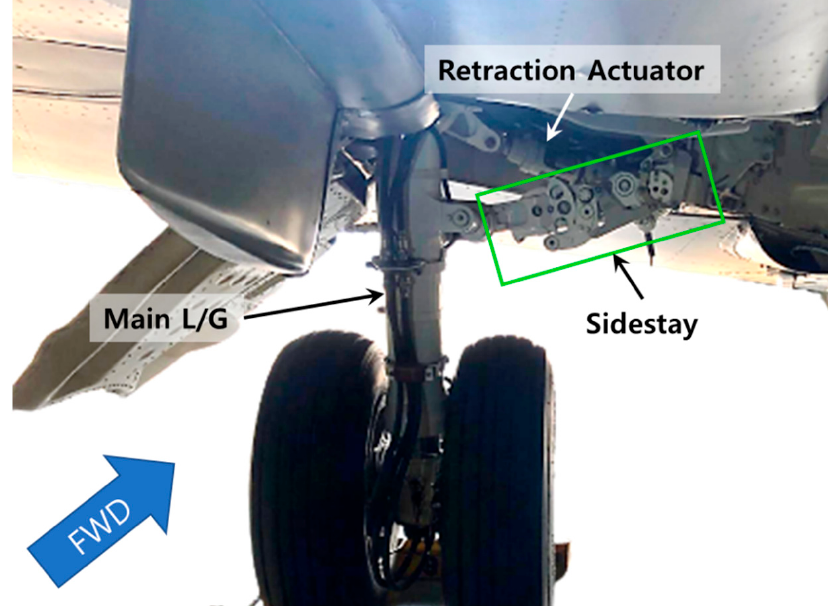
Figure 1. Hawker 800XP aircraft main landing gear structural components.